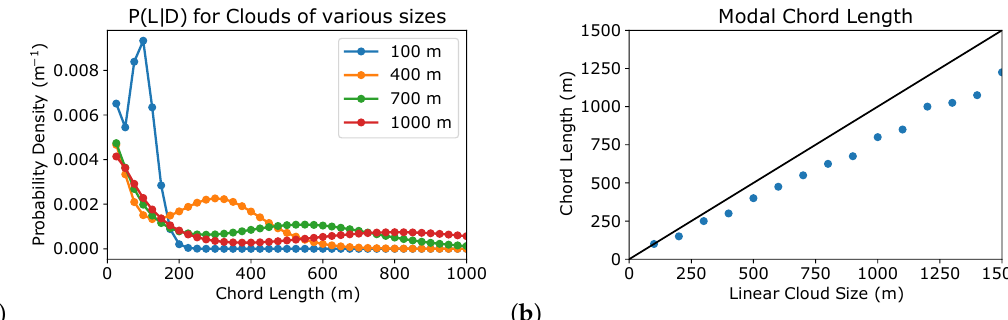
Figure 5. ( a ) Chord length distribution through all clouds with the same linear size in the 8th hour of the RICO simulation. ( b ) Modal chord length as a function of linear cloud